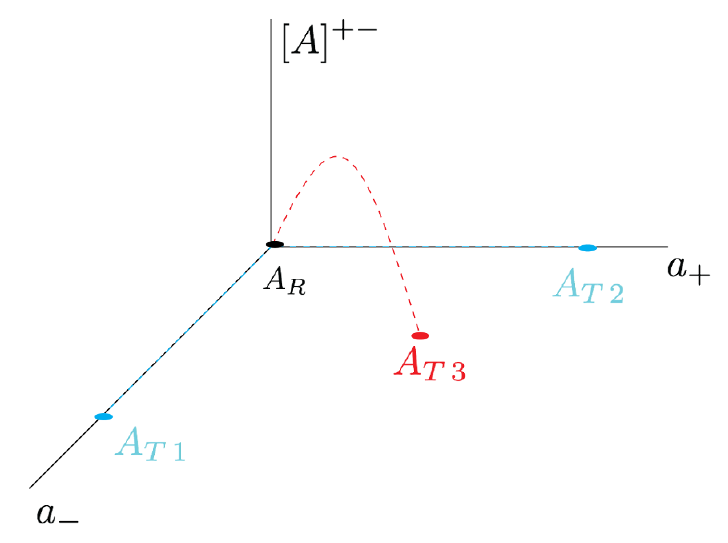
Figure 10 . Schematic diagram of the paths followed by the optimal circuits connecting the unen- tangled product state A to three di(cid:11)erent target states A . The states A and A have a + = 0 R T i T 1 T 2 and a (cid:0) = 0, respectively. The optimal circuits preparing such states in which only one of the normal modes is shifted remain in the x = 0 plane, i.e., [ A ] + (cid:0) = 0. Therefore the normal modes are unentangled for all of the states along these trajectories. In contrast, the trajectory preparing A begins and ends with [ A ] + (cid:0) = 0 but this component is nonvanishing everywhere away from T 3 these endpoints. That is, both the reference state and target state are unentangled but the optimal circuit introduces entanglement in the intermediate states when both a (cid:6) 6 = 0 in the (cid:12)nal